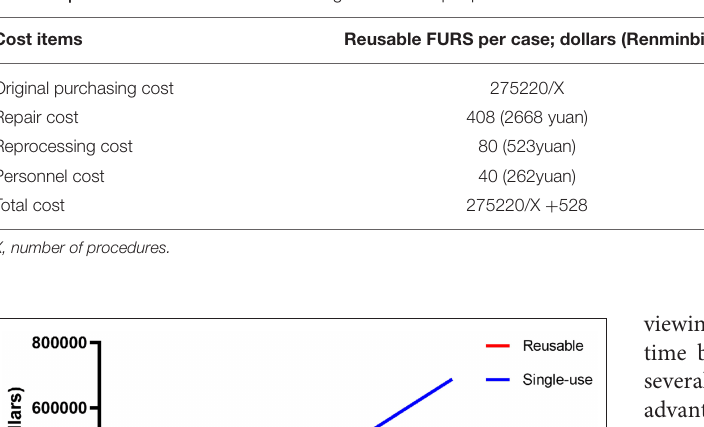
TABLE 3 | The costs of reusable FURS or single-use FURS per